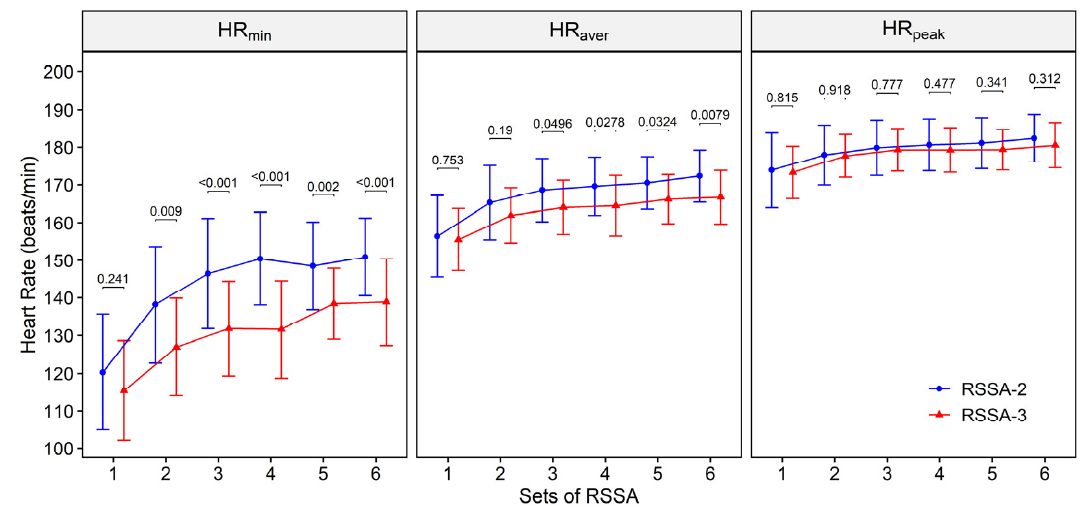
Figure 4. Heart rate response during RSSA-2 and RSSA-3 tests. P values between corresponding sets of RSSA-2 and RSSA-3 have been indicated above upper bars of 95% CI.